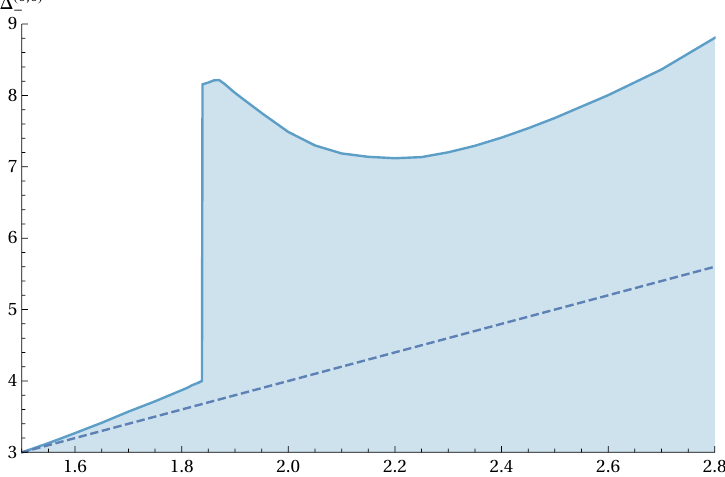
Figure 7 . Upper bound on the dimension of the (cid:12)rst charged scalar TS operator. The shaded region is the allowed one. The bound has been computed at (cid:3) = 20. The dashed line represents the GFT line. The bound has a discontinuity at (cid:1) (cid:25) 1 :